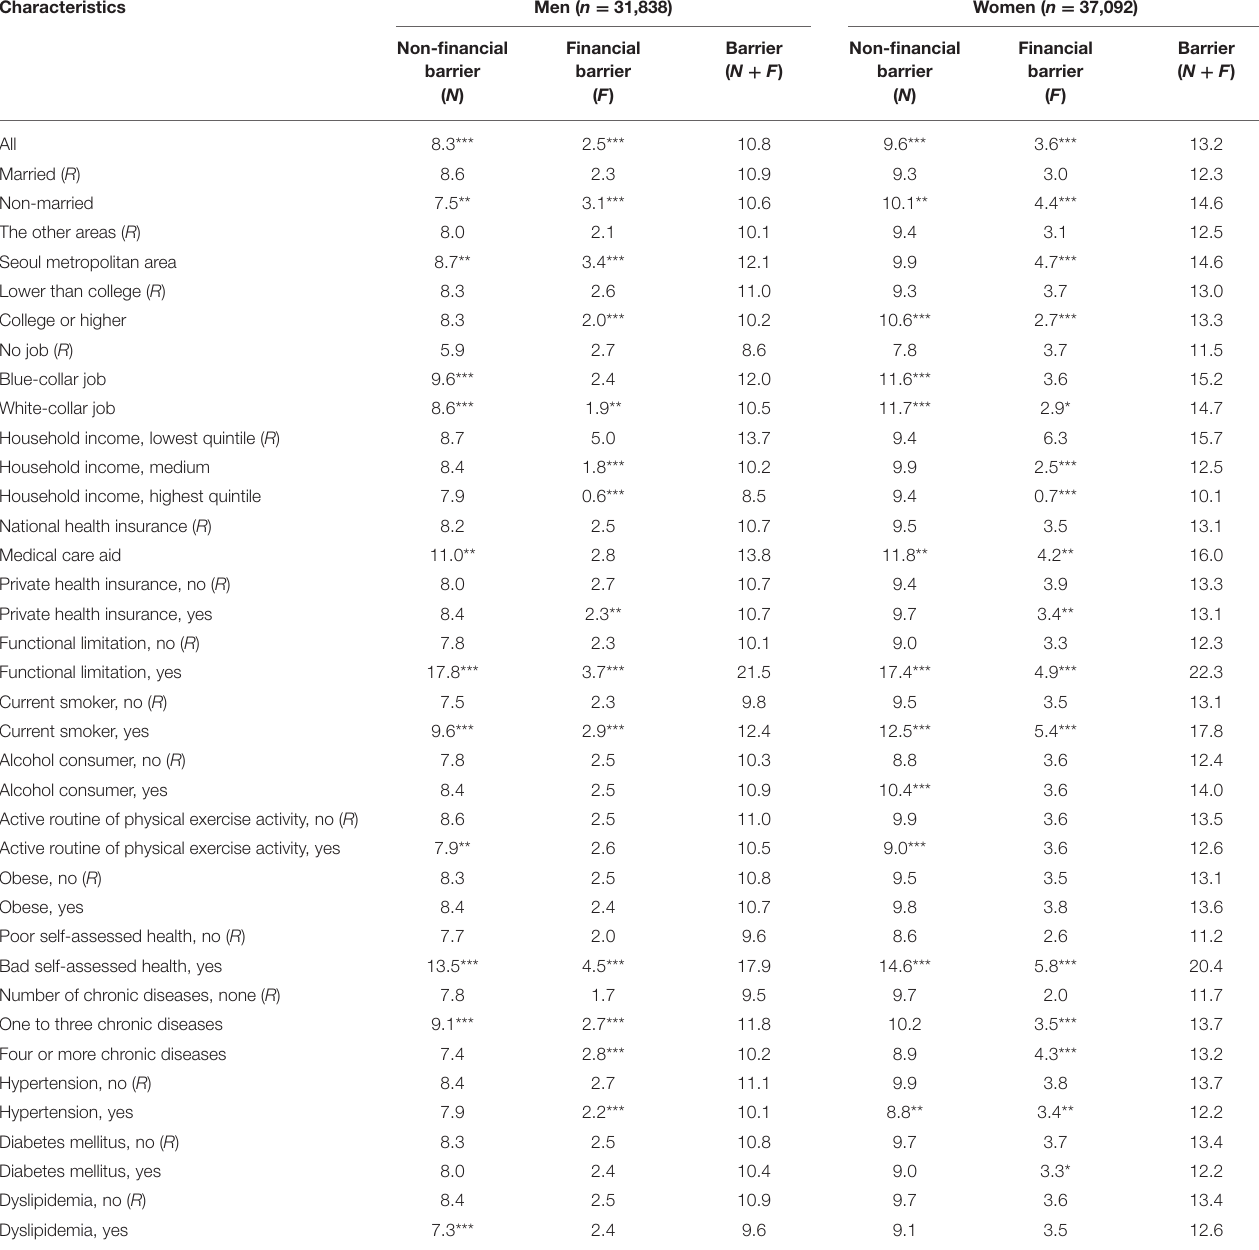
TABLE 3 | The average adjusted probabilities of experiencing non-financial or financial barriers that led to unmet healthcare needs.